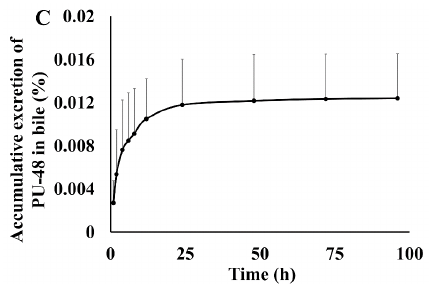
Figure 4. Feces, urinary and bile cumulative excretion profile of methyl 3-amino-6-methoxythieno [2,3-b] quinolone-2-carboxylate (PU-48) after single oral dose of 12 mg/kg in rats ( n = 6).